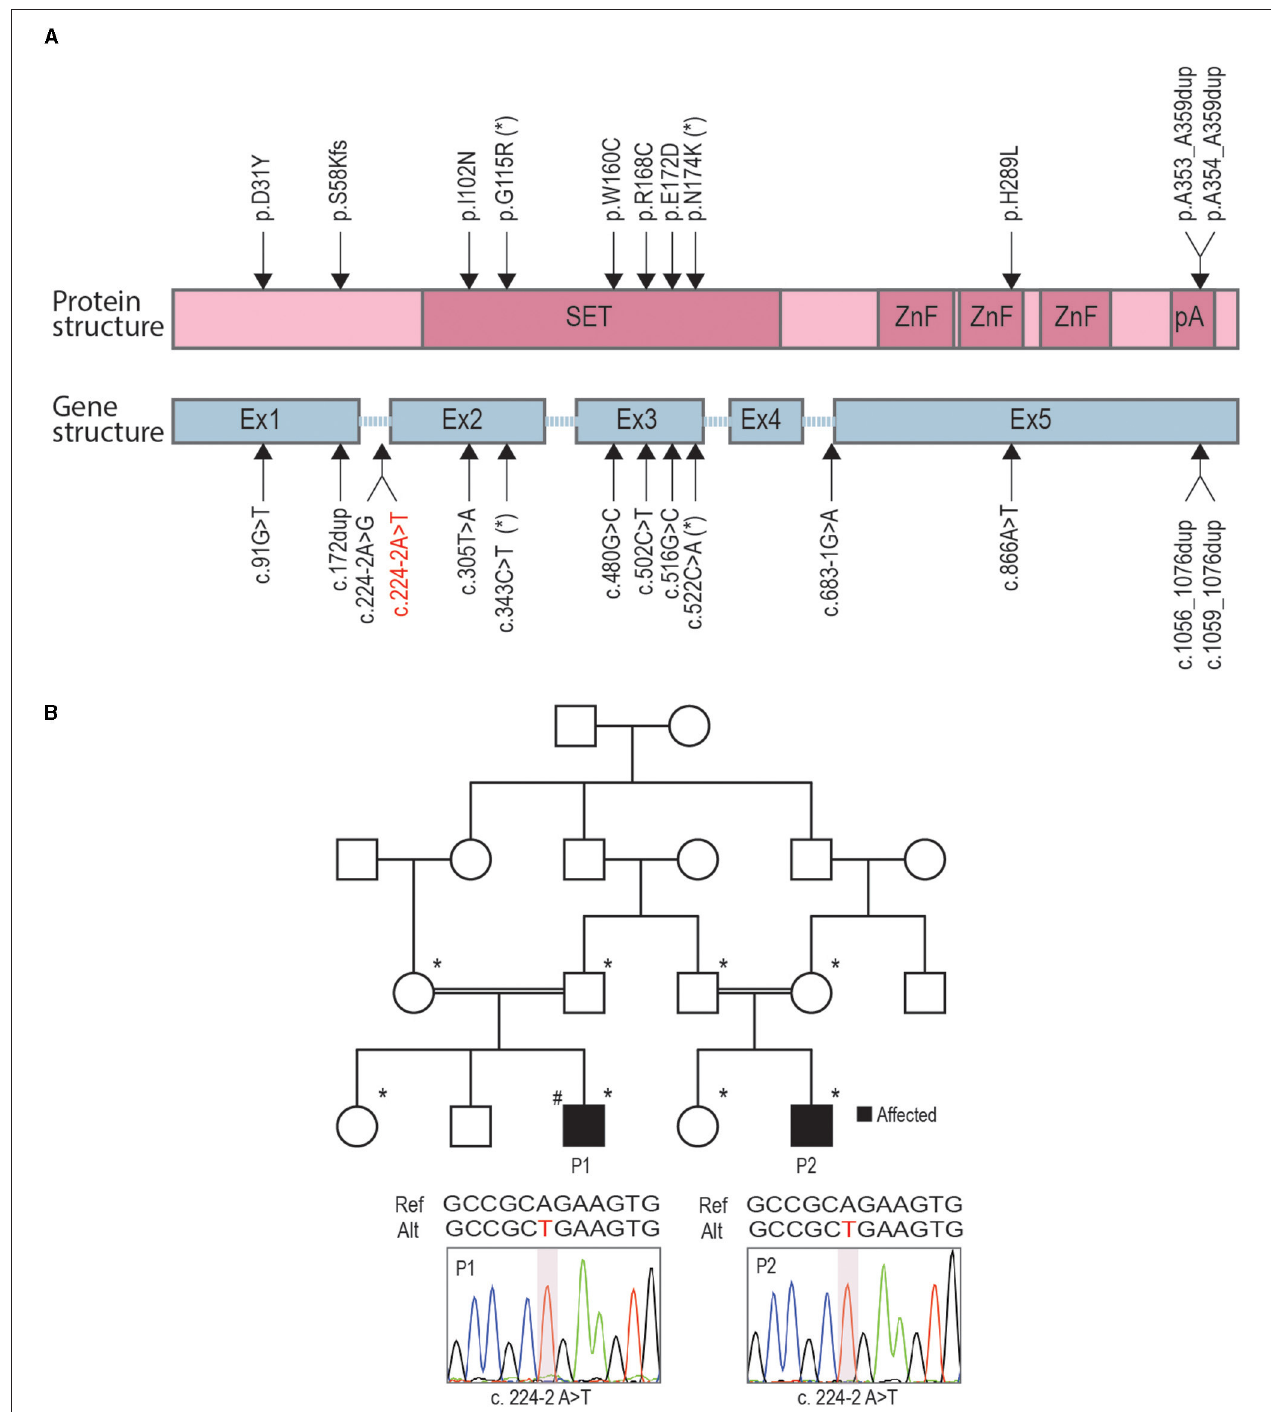
FIGURE 1 | Identification of novel variants in two related congenital insensitivity to pain (CIP) cases. (A) A schematic representation of PR-domain containing member 12 (PRDM12) protein domain structure (pink) and gene structure (blue) with marked locations of previously published causative CIP variants and a novel splice-site variant reported here (red letters). (B) Family pedigree, with affected individuals shaded in black; family members included in segregation analysis indicated with asterisks; hashtag denotes index patient (patient 1, P1) for which whole-exome sequencing (WES) was performed. The position of the missense mutation is depicted below the family pedigree for patients 1 (P1) and 2 (P2) with an illustrative Sanger chromatogram of genomic PCR amplicons.